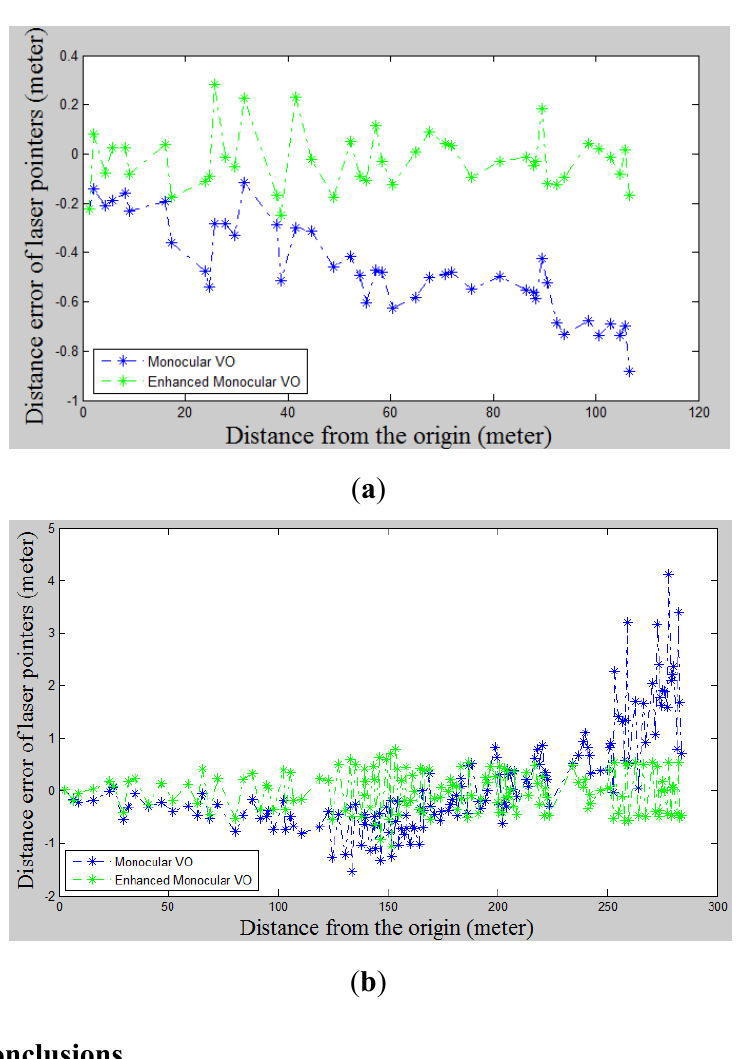
Figure 14. The distance error of the laser pointer with our enhanced monocular VO scheme compared to the traditional one. ( a ) the first dataset; ( b ) the second